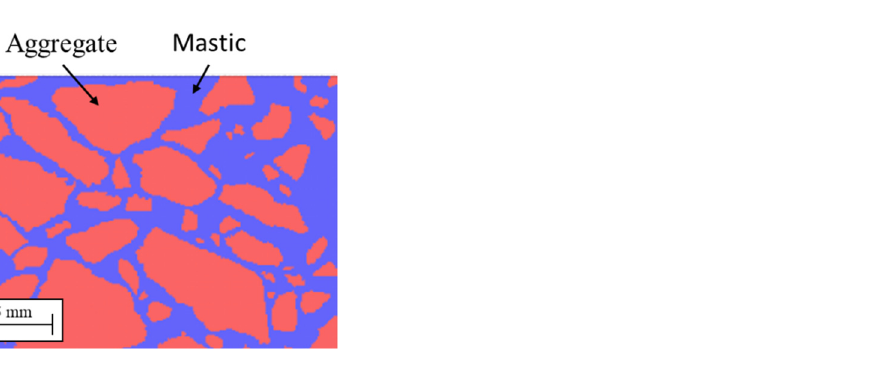
Figure 3. Asphalt (DA): blue particles represent the mortar; red particles represent the aggregate.